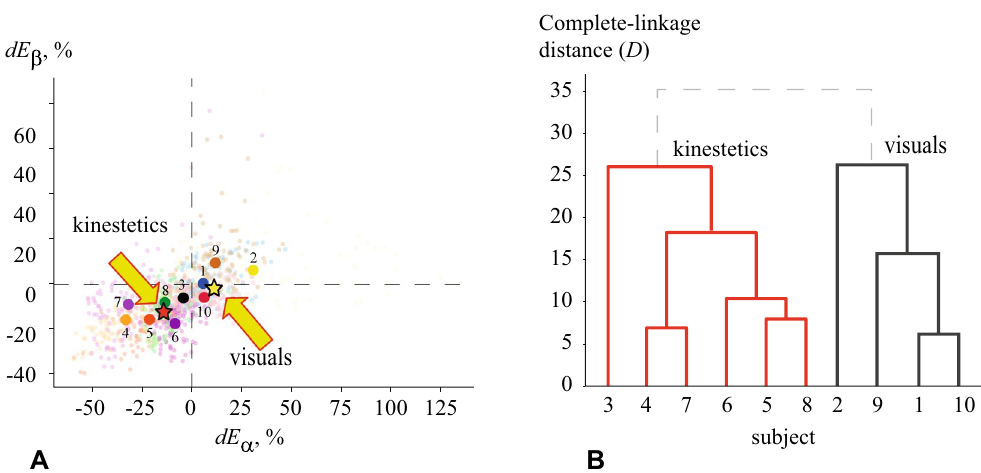
Figure 5. Results of hierarchical cluster analysis (HCA) illustrating the clustering of subjects belonging to KI and VI types. ( A ) Wavelet energy differences during MI in ( dE α , dE β ) feature space. Different colors indicate different subjects: clouds of small dots represent wavelet energy differences for i -th channel ( i = 1, … , N ) and big dots show differences in individual wavelet energy averaged over N = 102 channels. Stars show centroids of KI (red) and VI (yellow) clusters obtained by k -means clustering. ( B ) Dendrogram showing the formation of two subgroups (KI and VI) in terms of Euclidean distance between clusters in ( dE α , dE β ) feature